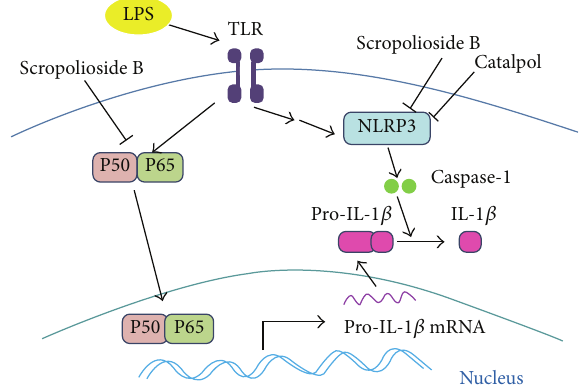
Figure 6: A schematic diagram of the regulation of NLRP3 inflam- masome by scropolioside B and